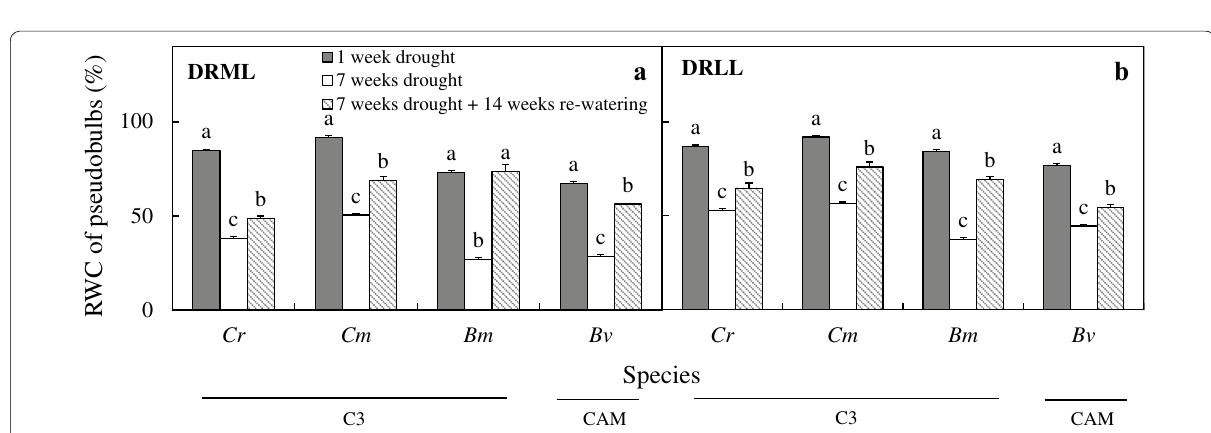
Fig. 6 RWC of pseudobulbs of C. rochussenii ( Cr ), C. mayeriana ( Cm ), B. membranaceum ( Bm ) and B. vaginatum ( Bv ) after 1 and 7 weeks of drought and after 14 weeks of re-watering under moderate light ( a ) and low light ( b ). Vertical bars represent standard error. Different letters above bars indicate statistical difference (Tukey’s multiple comparison, p < 0.05, n =